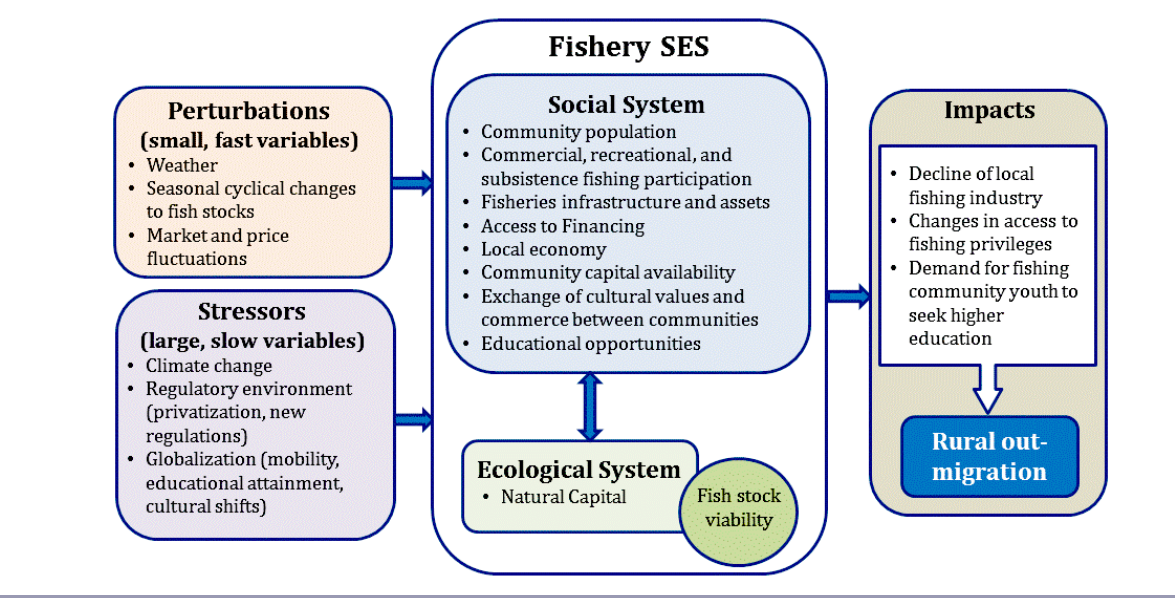
Fig. 2 . Examples of the dynamics of stressors and perturbations acting on components of an Alaska fishery social-ecological